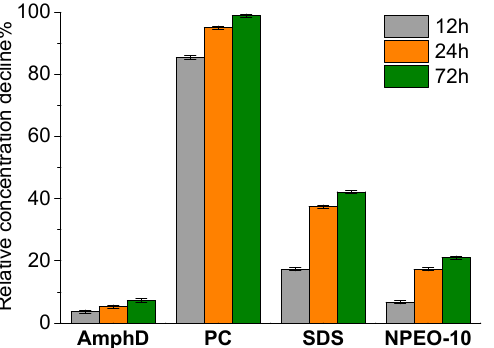
Figure 4. Relative concentration decline of HbCC dispersions with different dispersants.